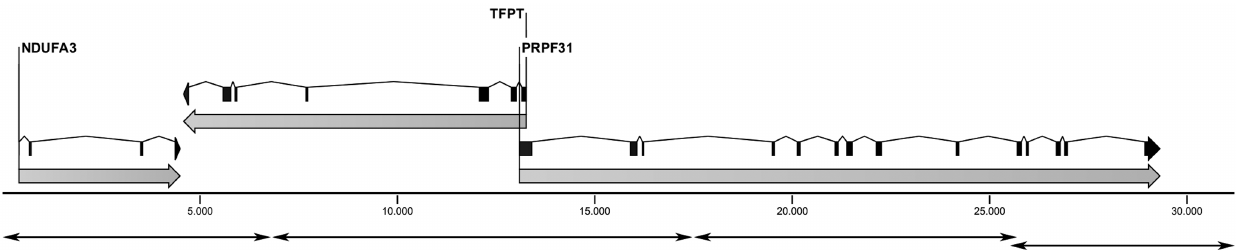
Figure 1. Schematic representation of the 31-kb genomic interval analyzed, containing the genes NDUFA3 , TFTP , and PRPF31 . Double- headed arrows indicate the position of the 4 amplicons used as template for UHTS.